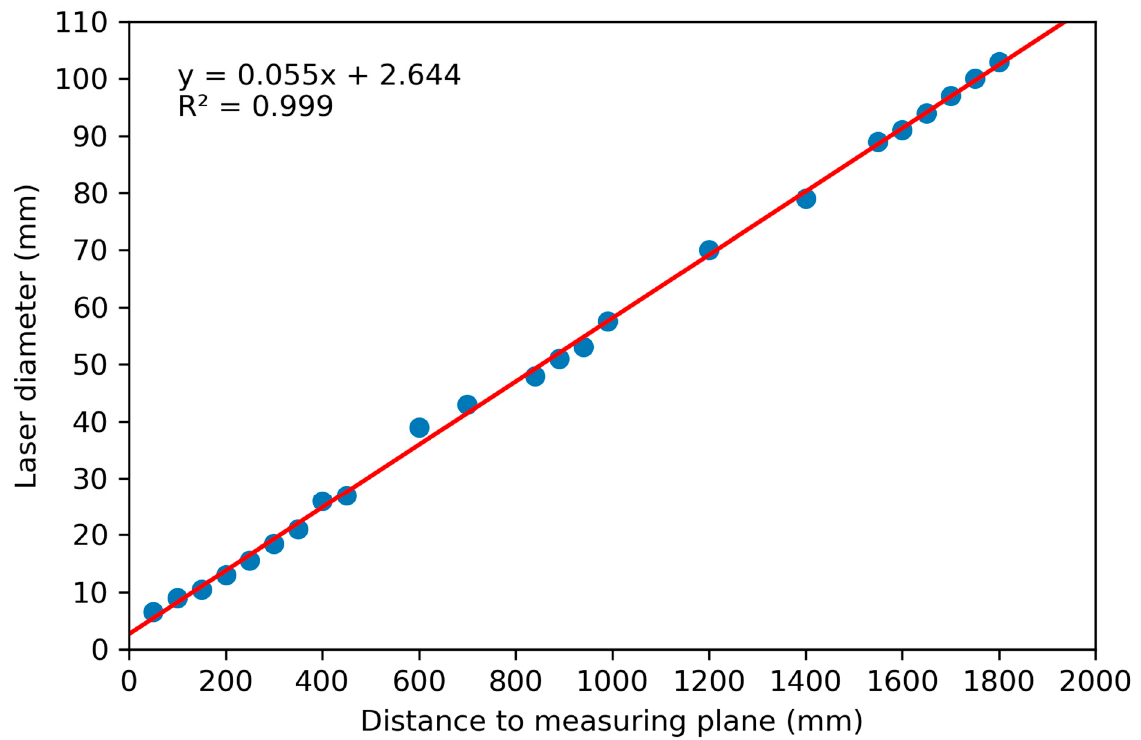
Figure 2. Relationship between distance to measuring plane and laser beam diameter.